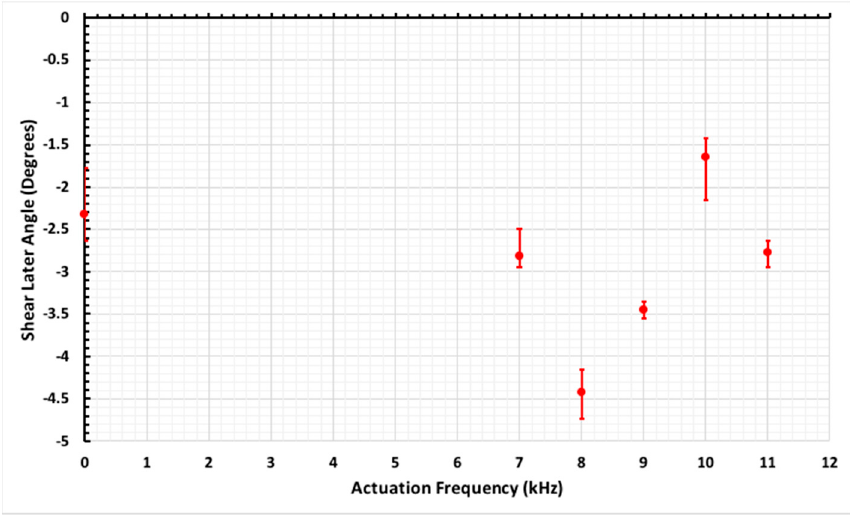
Figure 9. Averaged shear layer angle relative to the freestream direction at different actuation frequencies.